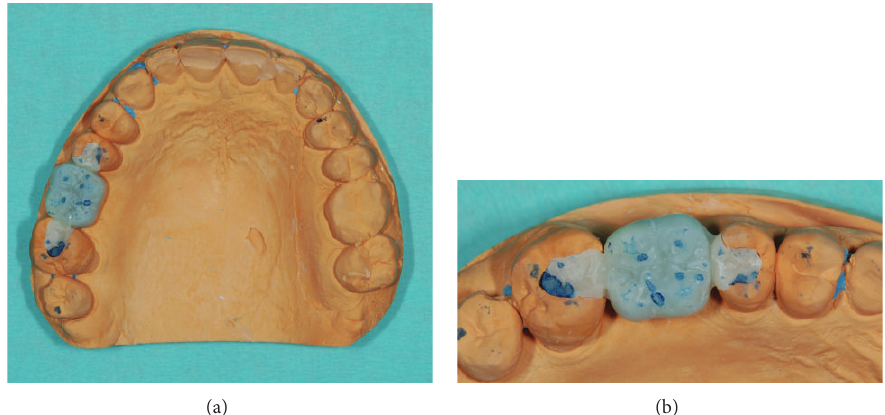
Figure 6: (a) Interarch relationships were highlighted with a 40 𝜇 occlusal paper. (b) Details of the contacts area; excessive occlusal pressure at the margins of the restoration will be corrected in the laboratory.